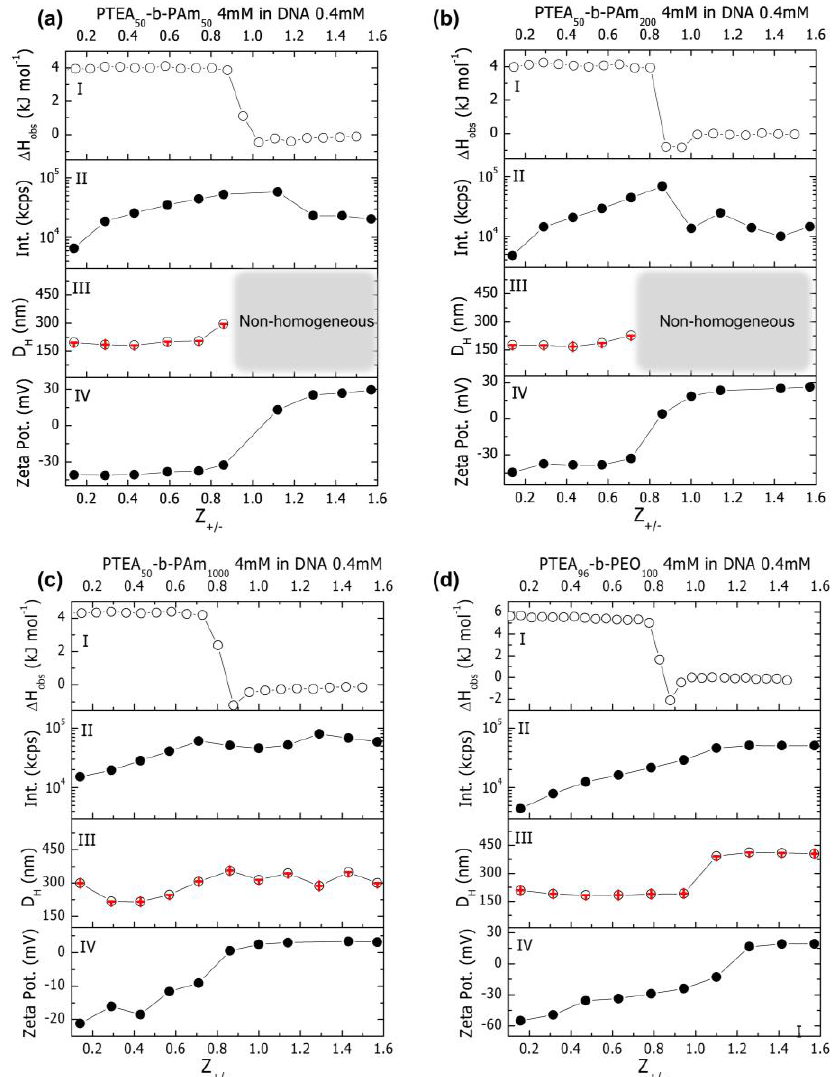
Figure 2. Comparison of ITC data with DLS results: intensity of scattering; hydrodynamic diameter (Z average ) with PDI values indicated as red bars; and zeta potential values for titration of DNA with (PTEA) 50 - b -(PAm) 50 ( a ), (PTEA) 50 - b -(PAm) 200 ( b ), (PTEA) 50 - b -(PAm) 1000 ( c ), and (PTEA) 96 - b -(PEO) 100 ( d ).